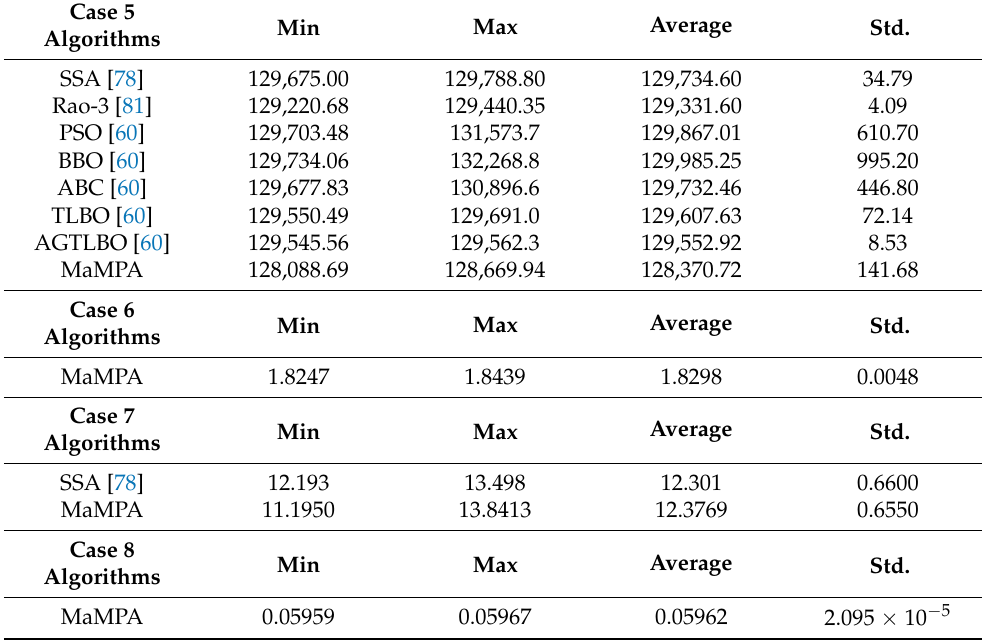
Table 10. Statistical comparison of MaMPA and other algorithms in the IEEE 118-bus